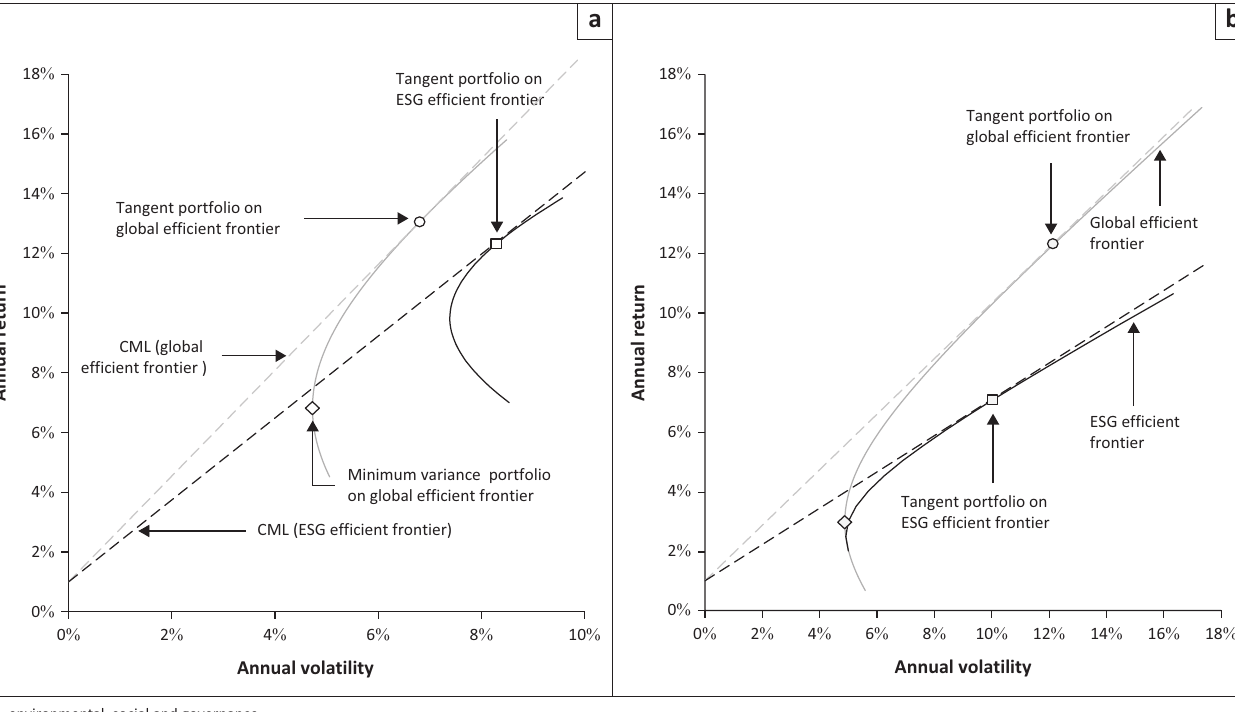
FIGURE 6: Global and environmental, social and governance (ESG)-efficient frontiers with associated capital market lines (CMLs), minimum variance portfolios and tangent (optimal) portfolios. In (a) optimal portfolios have similar return levels but the ESG portfolio has higher volatility (lower Sharpe ratio) and in (b) optimal portfolios have similar risk levels, but the ESG portfolio has lower returns (again, a lower Sharpe